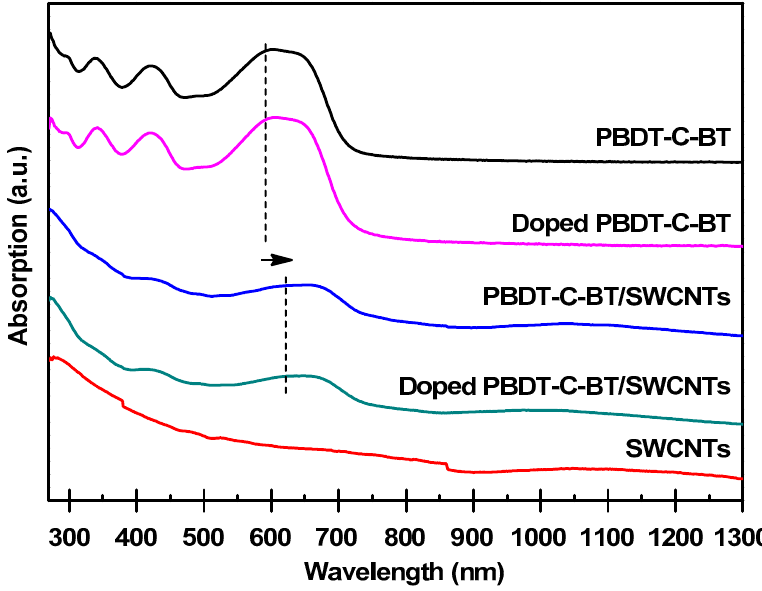
Figure 1. UV-Vis-NIR spectra of the PBDT–C–BT, SWCNTs, PBDT–C–BT/50 wt % SWCNTs (c) and F 4 TCNQ-doped PBDT–C–BT/50 wt % SWCNTs. All the spectra were recorded in airconditioned